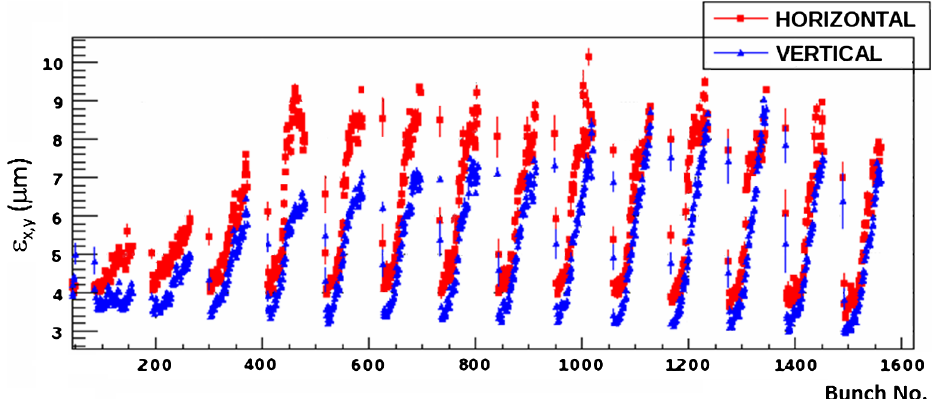
FIG. 12. Bunch-by-bunch normalized horizontal and vertical rms emittance in units of micron along multiple successive bunch trains measured by the gated synchrotron-light